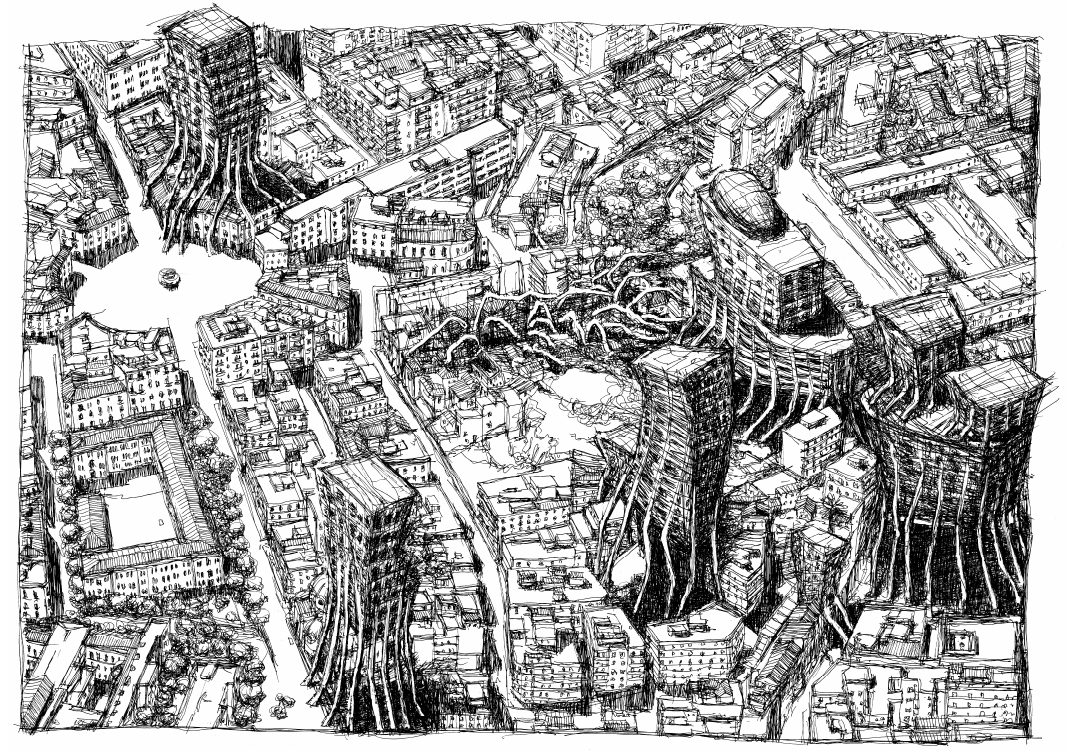
Figure 12. Michela De Domenico,